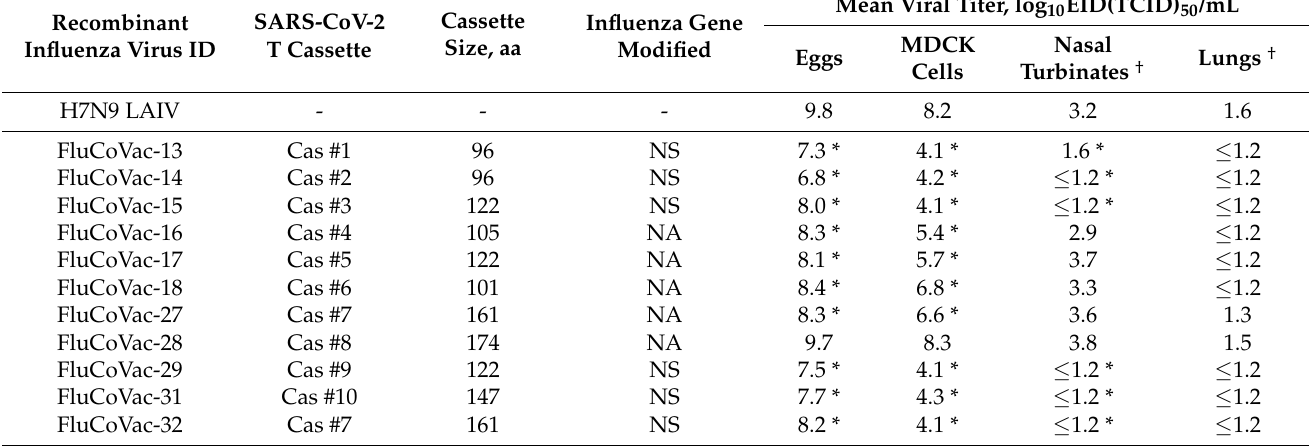
Table 1. The replicative properties of recombinant LAIV viruses in eggs, MDCK cells and respiratory tract of HLA-A2.1